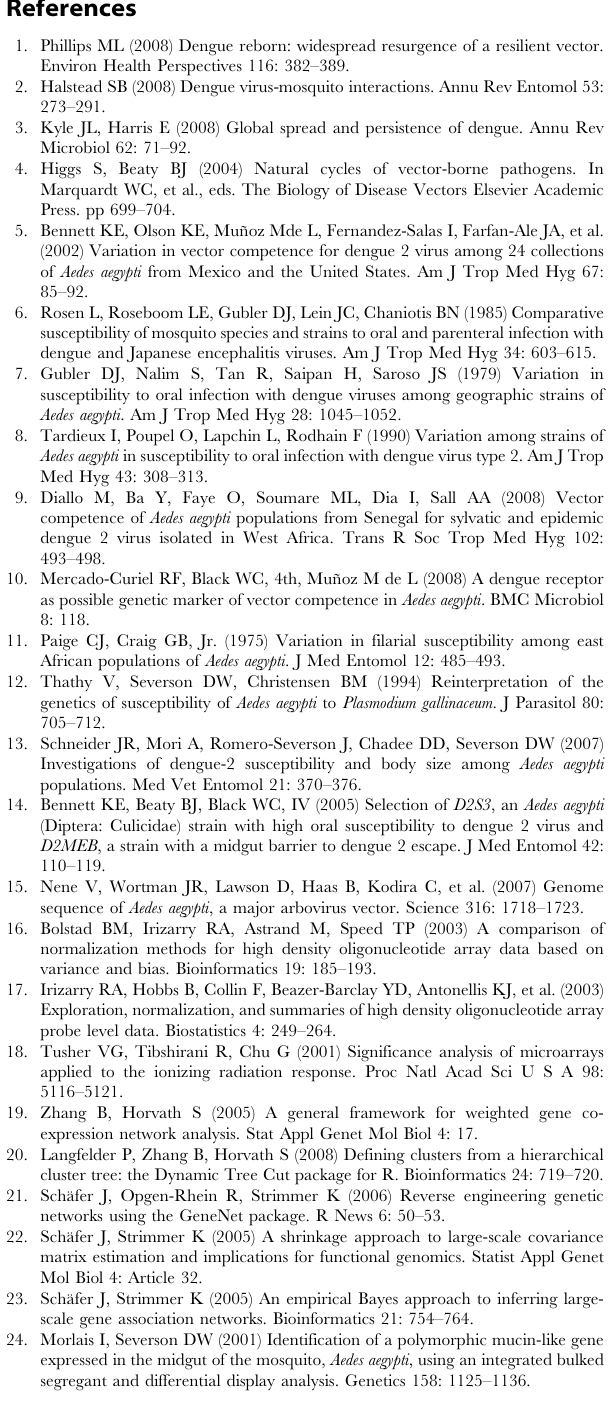
predicted modules wherein correlated expression patterns were